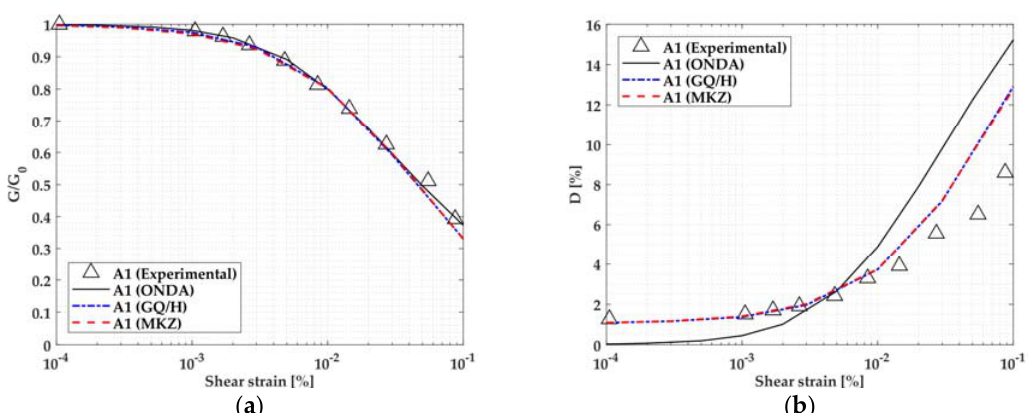
Figure 10. Comparison between the experimental and the adopted: ( a ) modulus reduction curve; ( b ) damping ratio curve (lithotype A1).